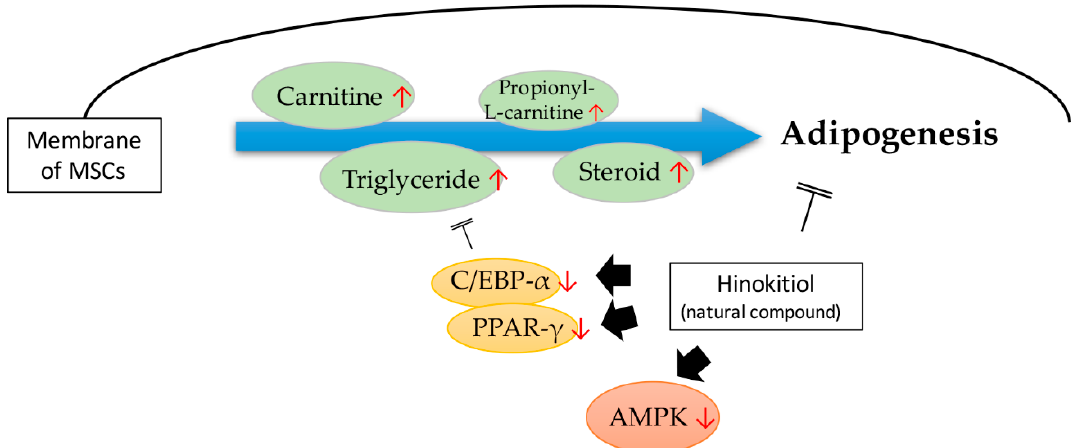
Figure 5. The effect of very low ‐ density lipoprotein (VLDL) ‐ containing TG in inducing MSC adipogenesis, and the type of induction that could be inhibited by the natural compound